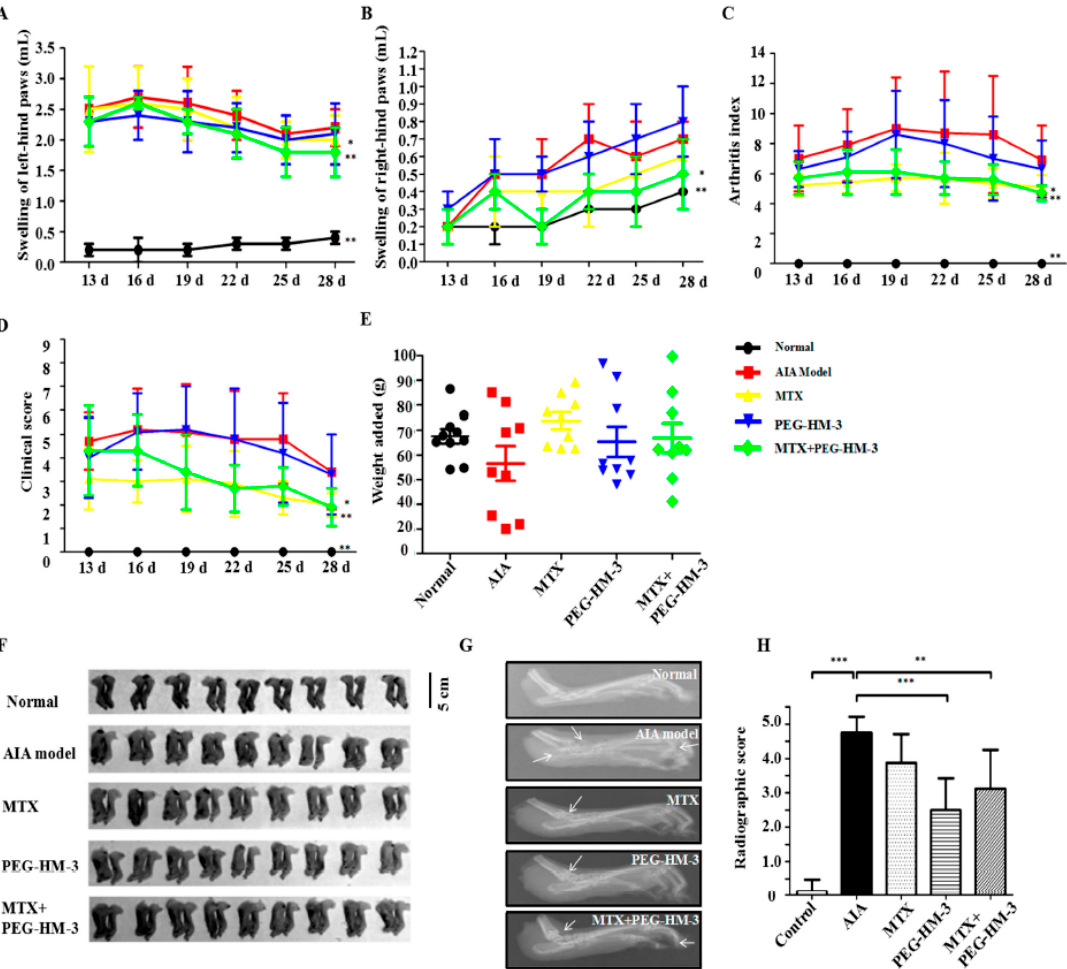
Figure 2. Curative effect of PEG-HM-3 alone or in combination with Methotrexate (MTX) on adjuvant-induced arthritis rats. All parameters were evaluated once every three days from the 13th day to the 28th day after disease onset (day 13, 16, 19, 22, 25, 28). ( A ) Swelling of the left-hind paws (mL); ( B ) Swelling of the right-hind paws (mL); ( C ) Arthritis index; ( D ) Clinical score; ( E ) Weight added (g) at the 28th day. MTX (1 mg·kg − 1 ), PEG-HM-3 (10 mg·kg − 1 ) and combination of MTX (1 mg·kg − 1 ) and PEG-HM-3 (10 mg·kg − 1 ) were used. Values are means and standard error of the mean (SD) (( A – E ), n = 9 in each group); ( F ) Morphology of the left- and right-hinds paws in each group; ( G ) X-ray exhibition of the left-hind paws of rats at the end of the experiment; ( H ) The radiographic analysis of the left-hind paws ( n = 8 in each group). Versus AIA model group. ** p < 0.01; *** p < 0.001.